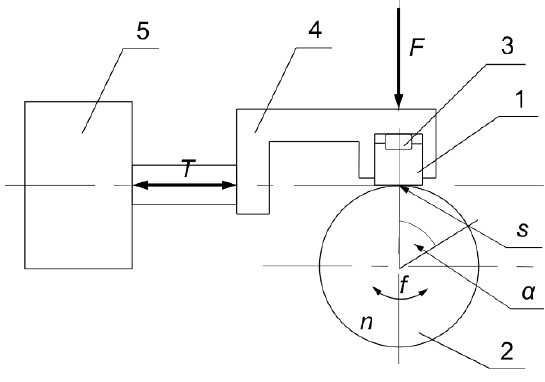
Figure 1. Scheme of the test stand (1 — specimen, 2 — counter-specimen, 3 — semicircular canopy, 4 — holder, 5 — force sensor [29].